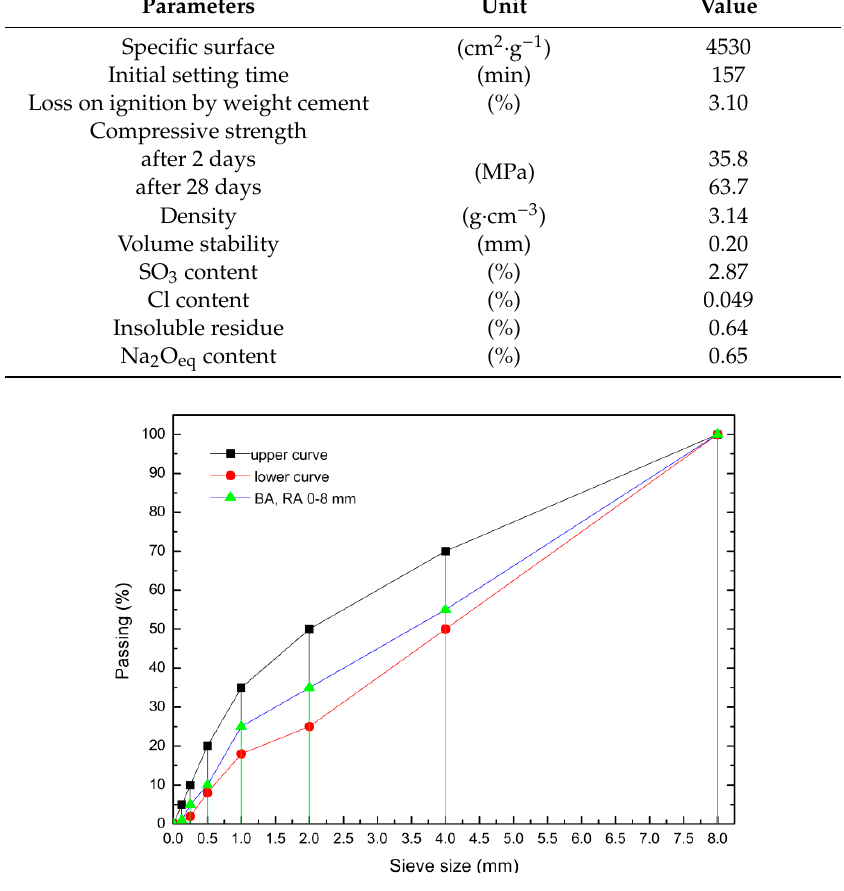
Table 2. Composition of concrete mixtures.